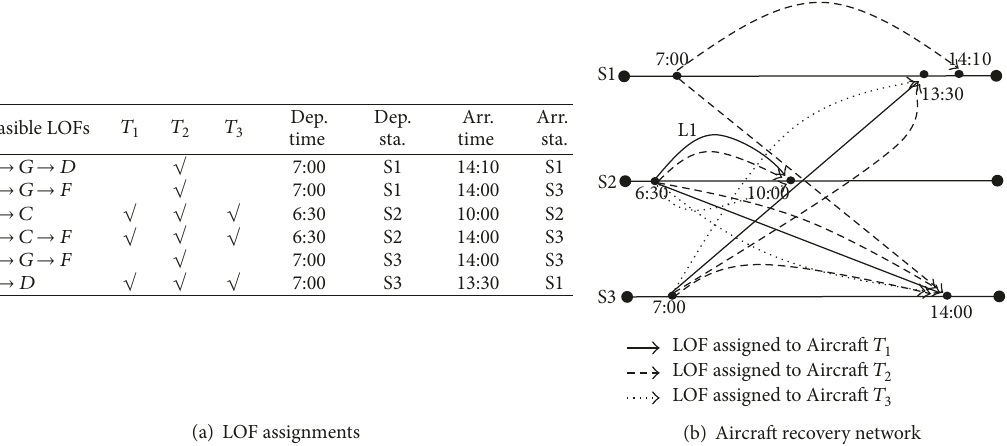
Sets, Elements, and